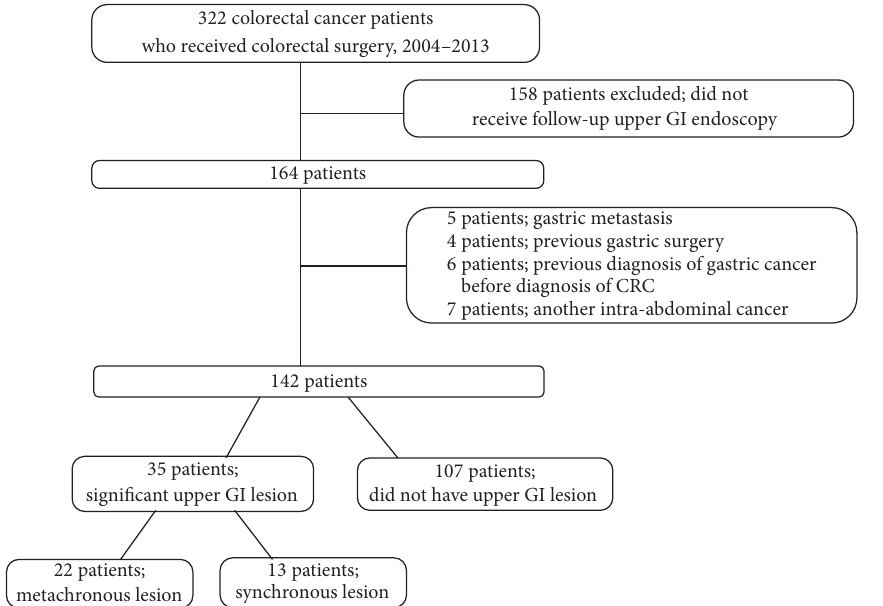
Figure 1: Study design and enrollment of patients. GI, gastrointestinal; CRC, colorectal